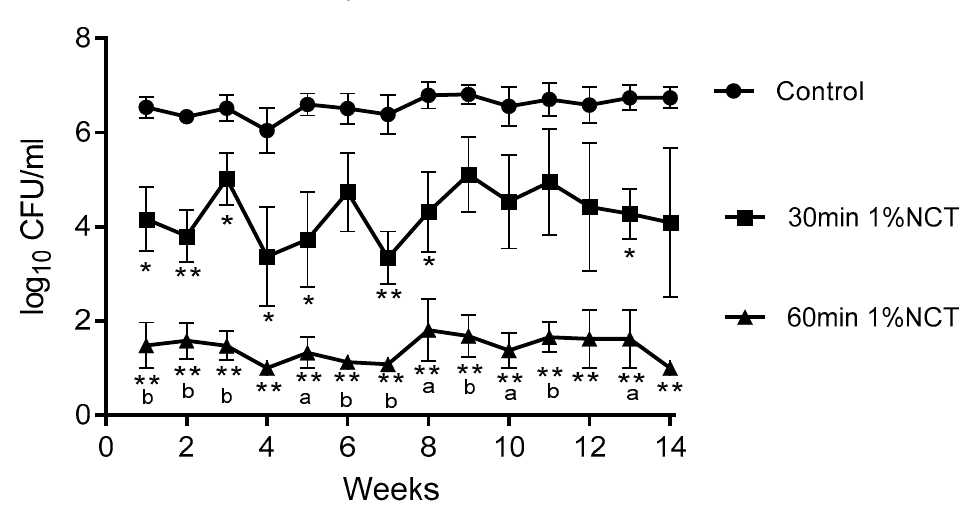
Figure 2. Bactericidal activity of 1% NCT at pH 7 and 37 °C against biofilms of P. aeruginosa ATCC 27853 grown for 14 weeks. Weekly evaluation by quantitative killing assays. Mean values ± SEM, n = 6 ( n = 4 for weeks 12 and 13, n = 3 for week 14); * p < 0.05 versus control; ** p < 0.01 versus control; a p < 0.05 versus 30 min NCT; b p < 0.01 versus 30 min